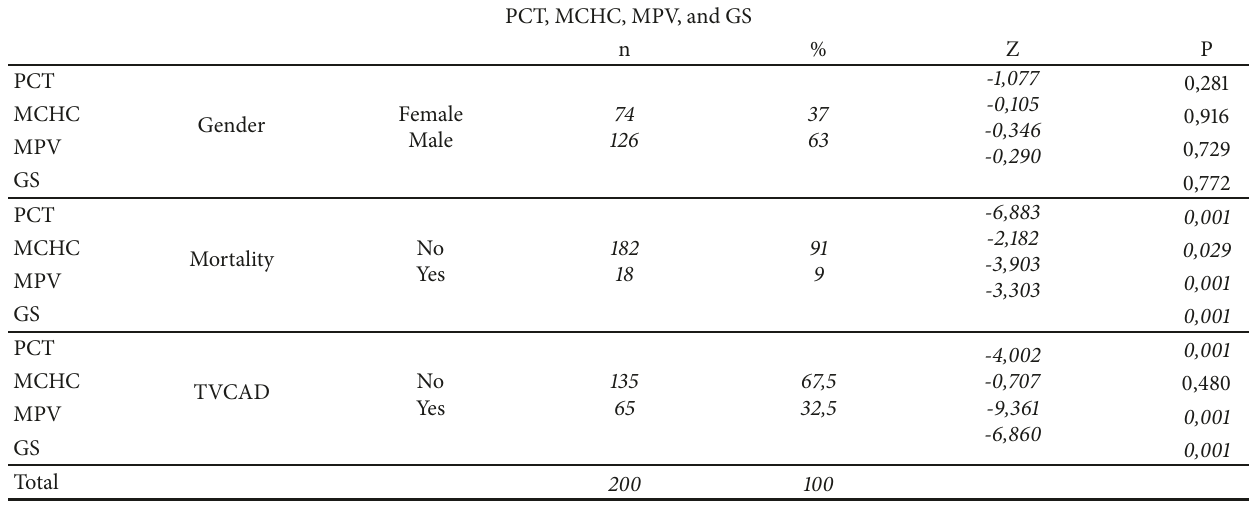
(a) Mann-Whitney U test for variance between ACS, gender, mortality, TVCAD, and complications in terms of values PCT, MCHC, MPV, and